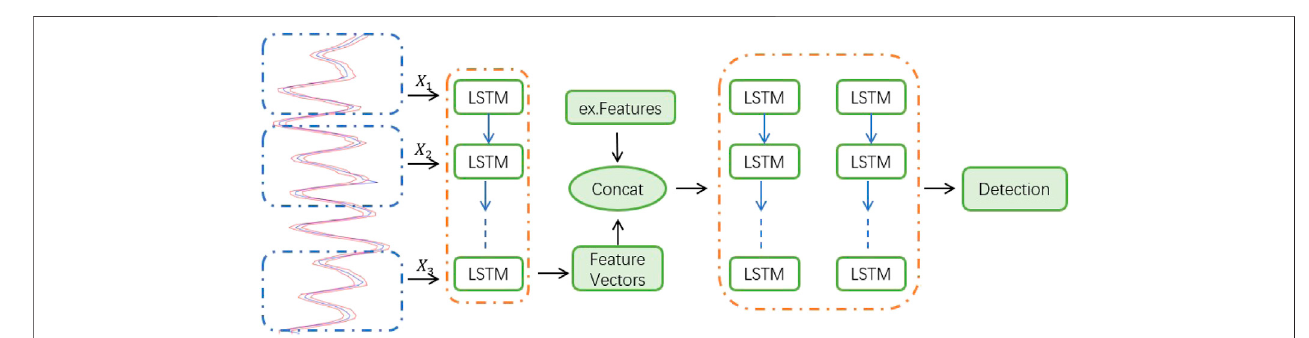
FIGURE 3 | QRNN architecture